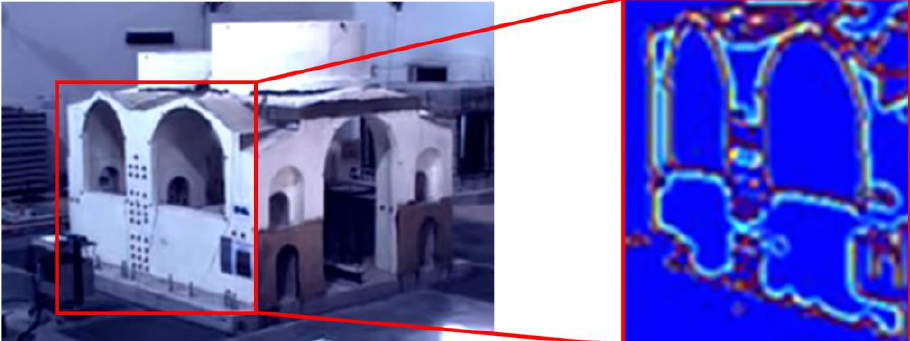
Figure 5. Skeletonization from the magnified video of a 1:10-scaled mock-up of Hagia Irene, Istanbul, Turkey.